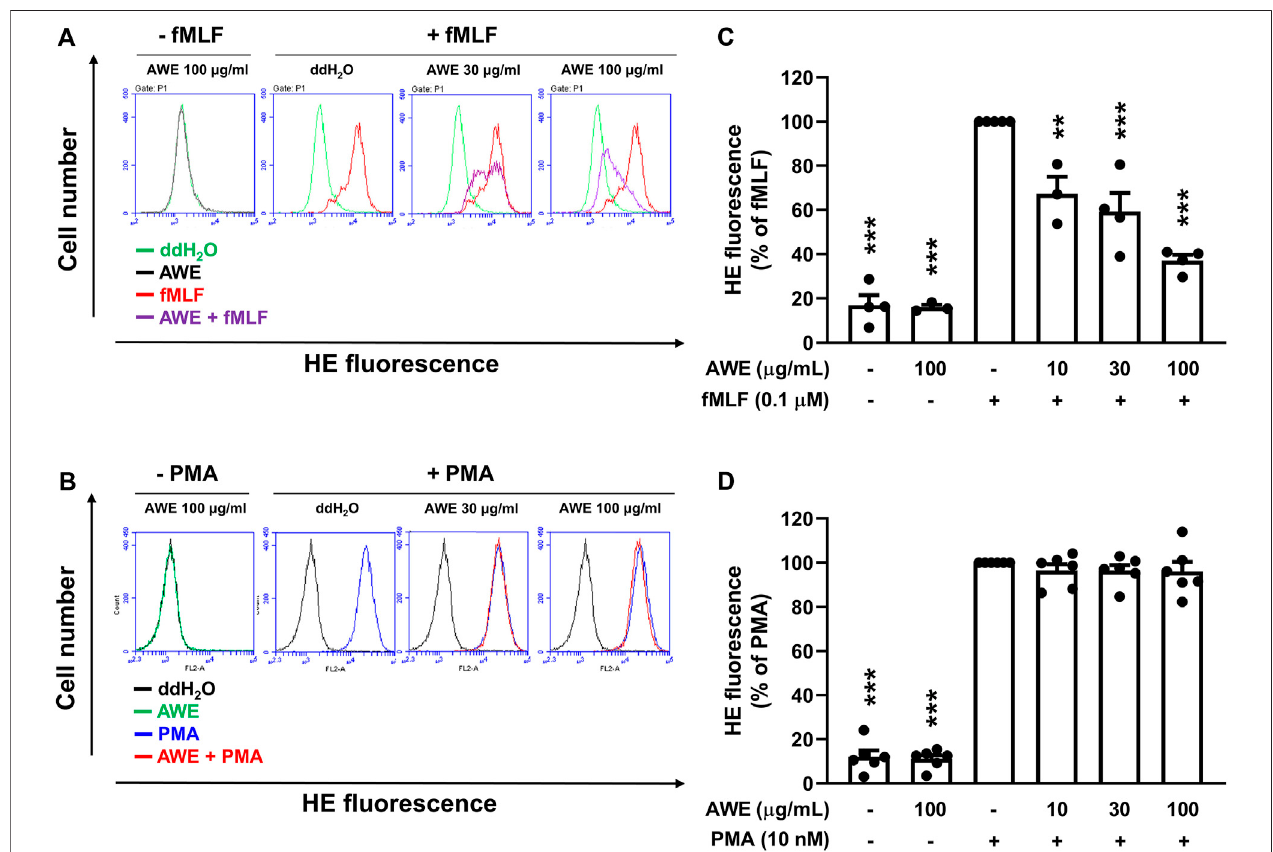
FIGURE 6 | AWE inhibits intracellular superoxide anion generation in fMLF-activated human neutrophils. Human neutrophils labeled with HE were incubated with ddH 2 O (as the control) or AWE (10, 30, and 100 μ g/ml) for 5 min and then stimulated with (A) fMLF (0.1 μ M) or (B) PMA (10 nM) for an additional 5 min. The representativehistogramsdemonstratingtypical fl uorescence-activatedcellsortingpro fi lesareshown.Mean fl uorescenceintensitiesareshownas (C) and (D) .Dataare expressed as the mean ± S.E.M. ( n (cid:2) 3 – 6). Statistical analysis was conducted using the one-way analysis of variance (ANOVA), followed by Tukey ’ s multiple comparison test if there were statistical differences in the results of ANOVA. Adjusted p -values of Tukey ’ s multiple comparison tests were de fi ned as *** p < 0.001 and ** p < 0.01 compared with the